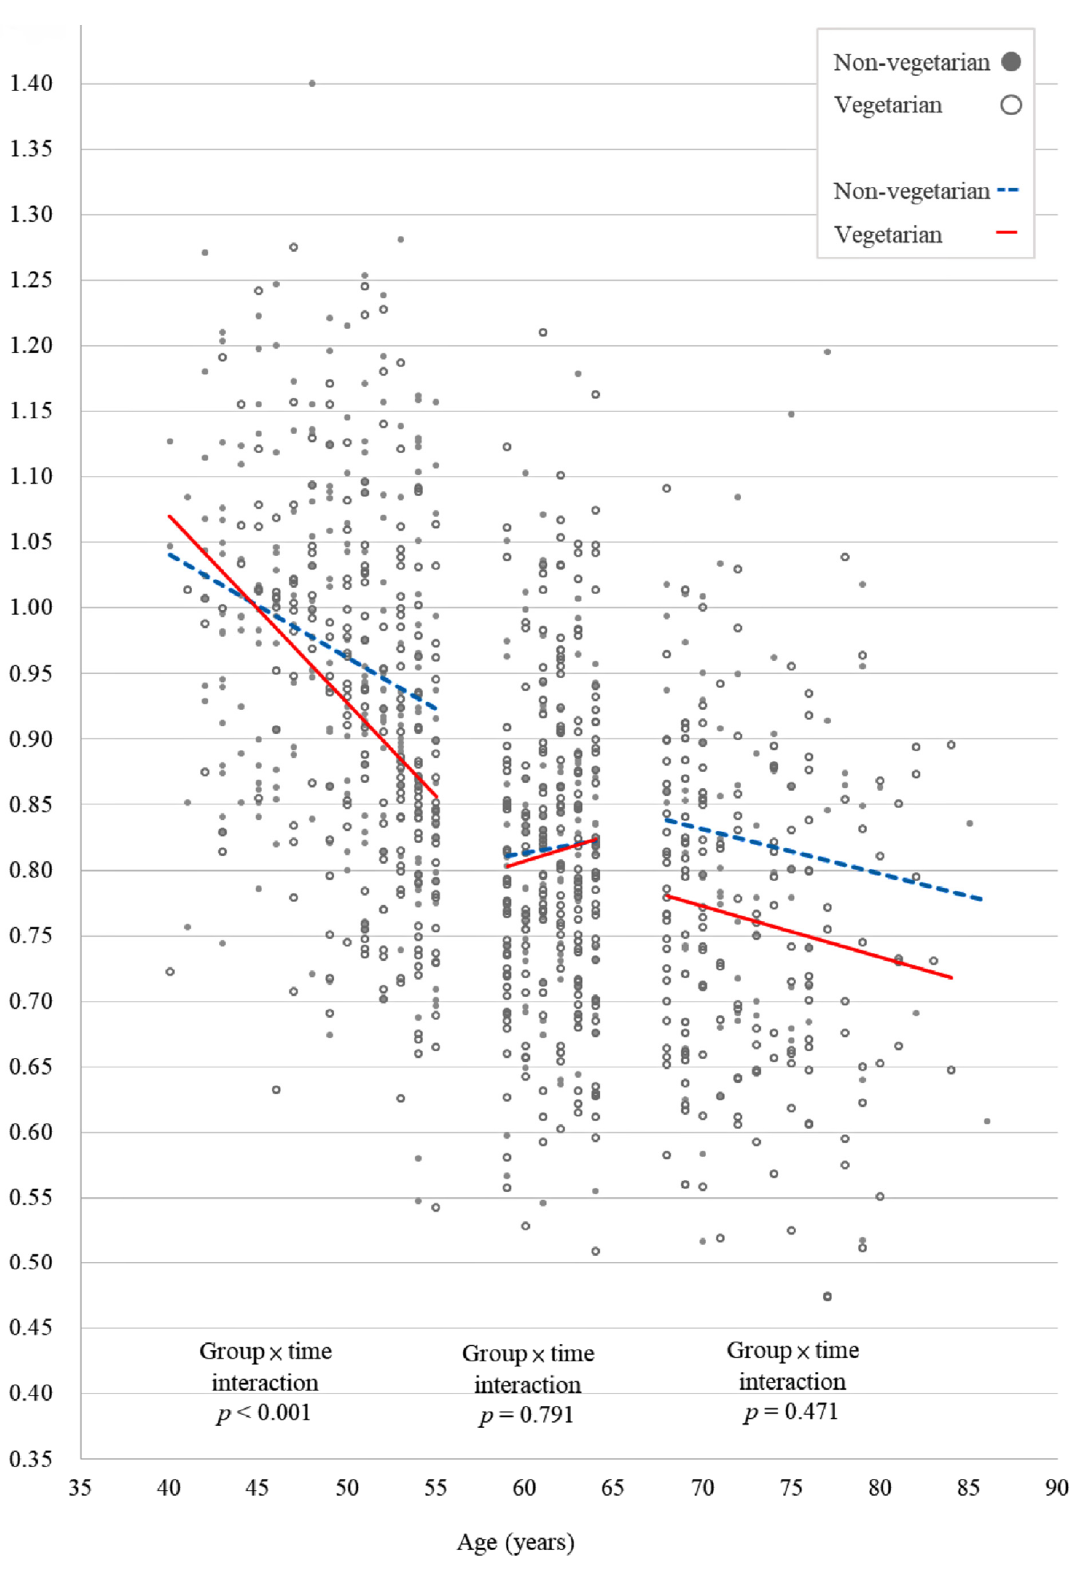
Figure 1. A scatter plot of the effect of the interaction between time and diet on lumbar spine bone mineral density in the three age groups of vegetarian and non-vegetarian women.